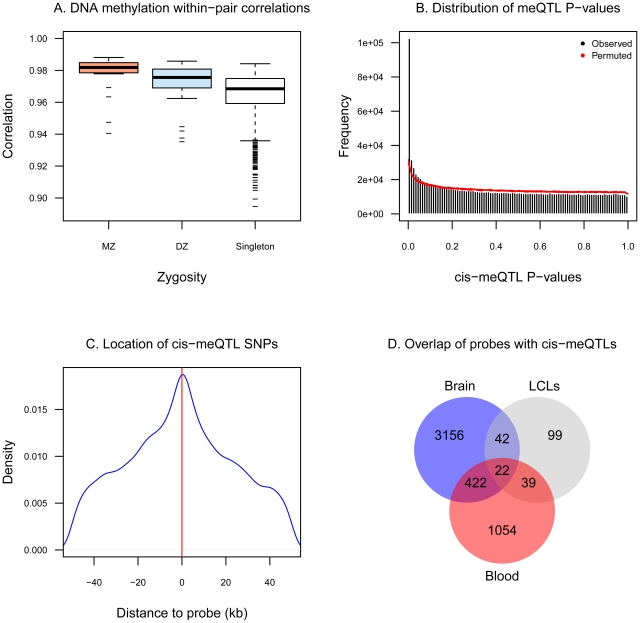
DNA methylation variation associates with genetic variation.A. Genome-wide pair-wise correlation coefficients in 21 pairs of MZ twins, 31 pairs of DZ twins, and 1091 pairs of unrelated individuals. B. Histogram of the observed distribution of P-values (black bars) and the expected distribution (red area indicates 90% confidence region) obtained from ten permutations of the data. C. Majority of SNPs that are cis-meQTLs are located within few kb of the methylation probe. D. Overlap of probes that have cis-meQTLs from the current study (red) with probes reported to have meQTLs in brain tissues (blue, [3]) and in LCLs (grey, [1]), not accounting for SNP overlap.